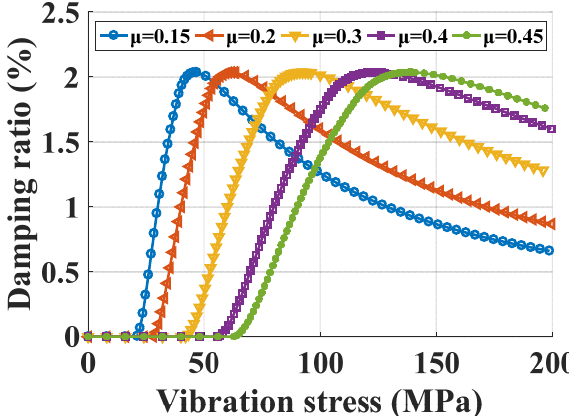
Figure 21. Damping characteristics at different friction coefficients for labyrinth seal.